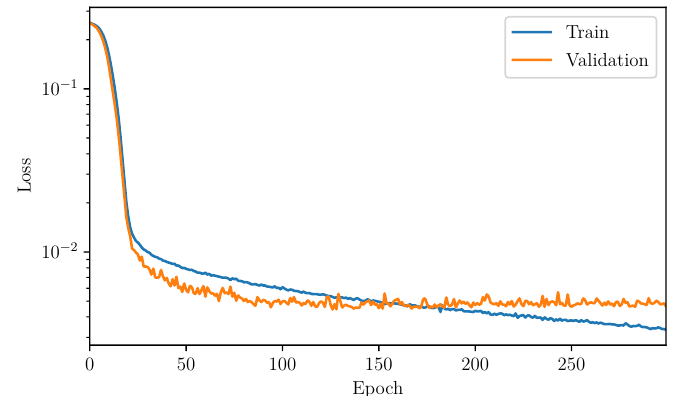
Figure 5. Loss functions for the validation set and the train set at each iteration (Epoch) during